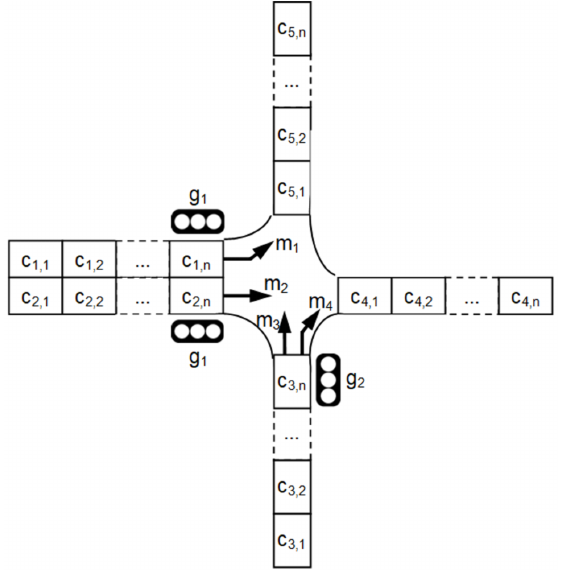
Figure 2. Example of signalized